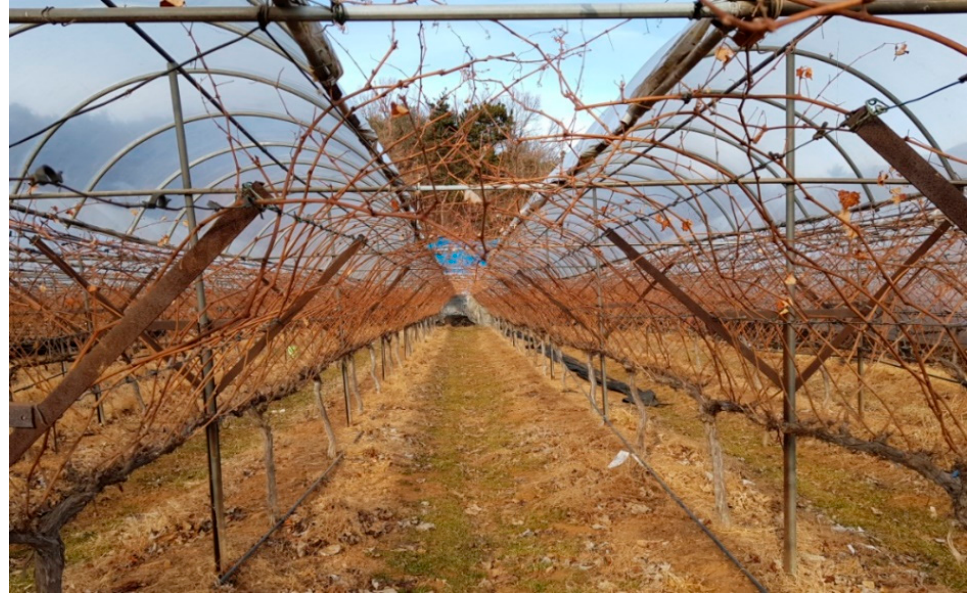
Figure 2. Rain-hit-protection facility in a grape farm.